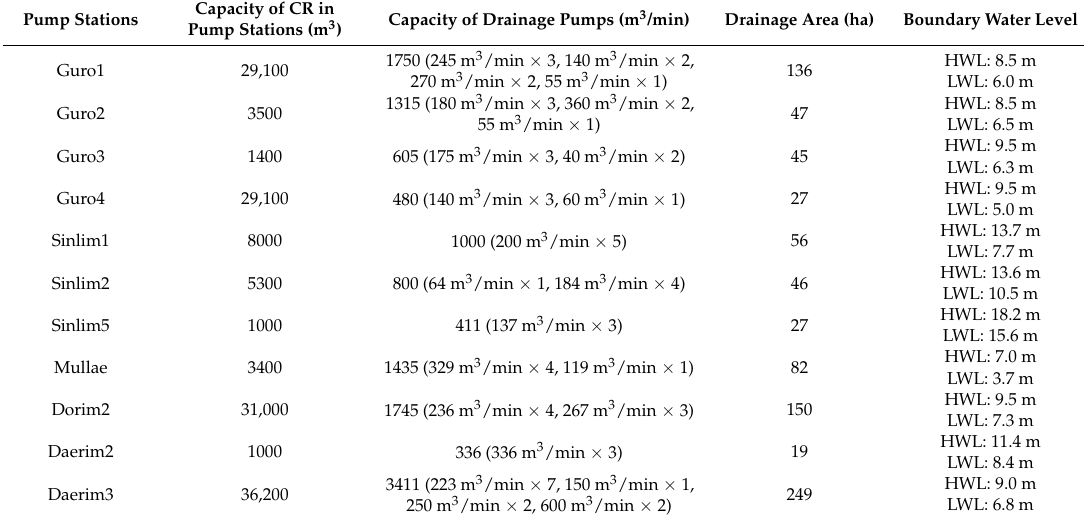
Table 4. Information on pump stations in the target